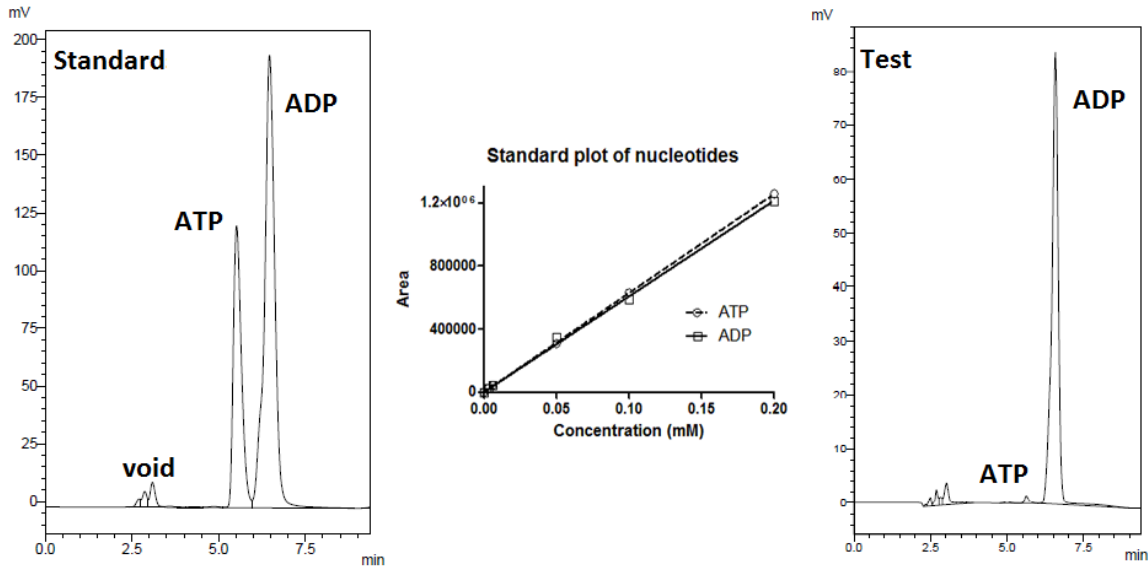
Figure 5: Chromatographic procedures employed for the separation, detection and estimation of ADP and ATP. The left panel shows chromatographic profile of a mixture of high amounts of ATP and ADP (0.33 and 0.76 mM respectively) at 254 nm. The middle panel is the standard plot for ADP & ATP at 254 nm. The right panel shows a sample chromatogram from the experiments (No. 4 of data Table 6). The reaction of ADP+Pi with superoxide showed non-specific products also (eluting after 10 min., result not shown).